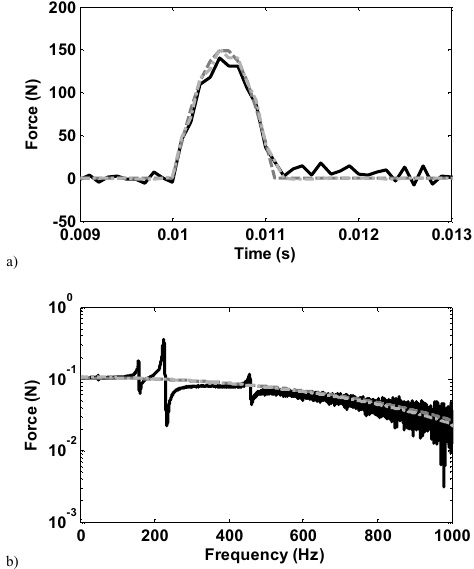
Fig. 11. The original force estimate (——), the actual force (– – –), and the new curve-fit force estimate (– · – · ) in the a) time and b) frequency domains. above analysis. The curve-fit force estimate after its Fourier transform coefficients are adjusted to account for energy that is lost in the curve-fitting process is shown in Fig. 11. It is evident that the peak force increases as well as the DFT coefficients, and the adjusted, curve-fit estimate better matches the actual forcing function. The new curve-fit DFT coefficients also better match the original, non-curve-fit force estimate coefficients at frequencies unaffected by the damage, e.g., for frequencies less than 175 Hz. One adverse effect stemming from the energy adjustment process is that the new curve-fit force estimate has slight oscillations before and after the main lobe of the force in the time domain because the DFT coefficients no longer match a forcing function in which the force is equal to exactly zero before and after the impact. However, the oscillations have very small amplitudes (less than 2 N peak-to-peak), so the small oscillations contain a very small amount of the total energy of the signal and are neglected (but not